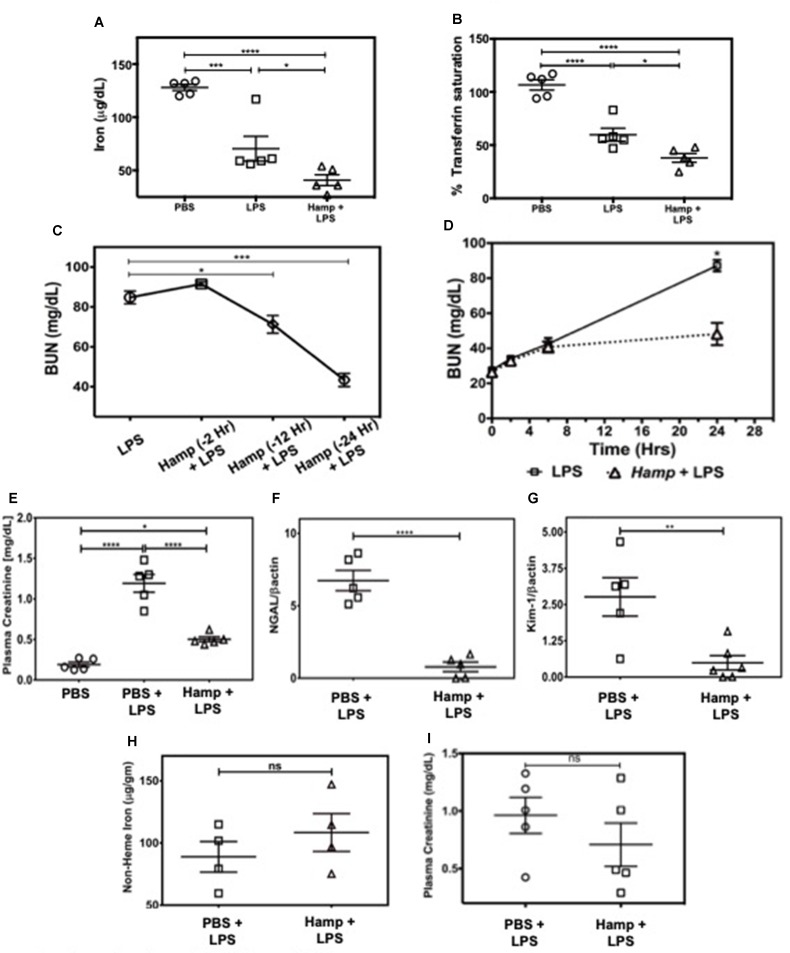
Hamp pretreatment reduces LPS-induced AKI. Mice were injected Hamp (50 µg/mouse, I.P.) 24 hrs before receiving 6.5 mg/kg LPS and euthanized 24 hr later to measure serum iron and transferrin saturation. Compared to PBS, LPS administration significantly decreased serum iron and transferrin saturation, both of which were further significantly reduced by Hamp pretreatment (A-B). Hamp (50 µg/mouse, I.P.) was administered 2, 12 or 24 hr before LPS (6.5 mg/kg). BUN was measured 24 hours later (C). Mice ptretreated with PBS or Hamp 24 hours before LPS administration were tail bled at 0, 2, 6 and 24 hours to measure changes in BUN (D). Hamp pretreatment protected the kidneys and reduced LPS-induced increase in plasma creatinine (E), NGAL (F), and KIM-1 (G) gene expression. Non-heme iron was measured following acid digestion of kidney (H), normalized to tissue weight and expressed as micrograms per gram of tissue. Hamp treatment did not significantly reduce plasma creatinine, an indicator of renal function when injected 3 hrs after LPS (I). *P < 0.05, **P < 0.005, ***P < 0.0005, ****P < 0.0001. Data points are plotted as mean ± SEM (n = 4-5 per group). Experiments were repeated twice and representative data from a single experiment is depicted.